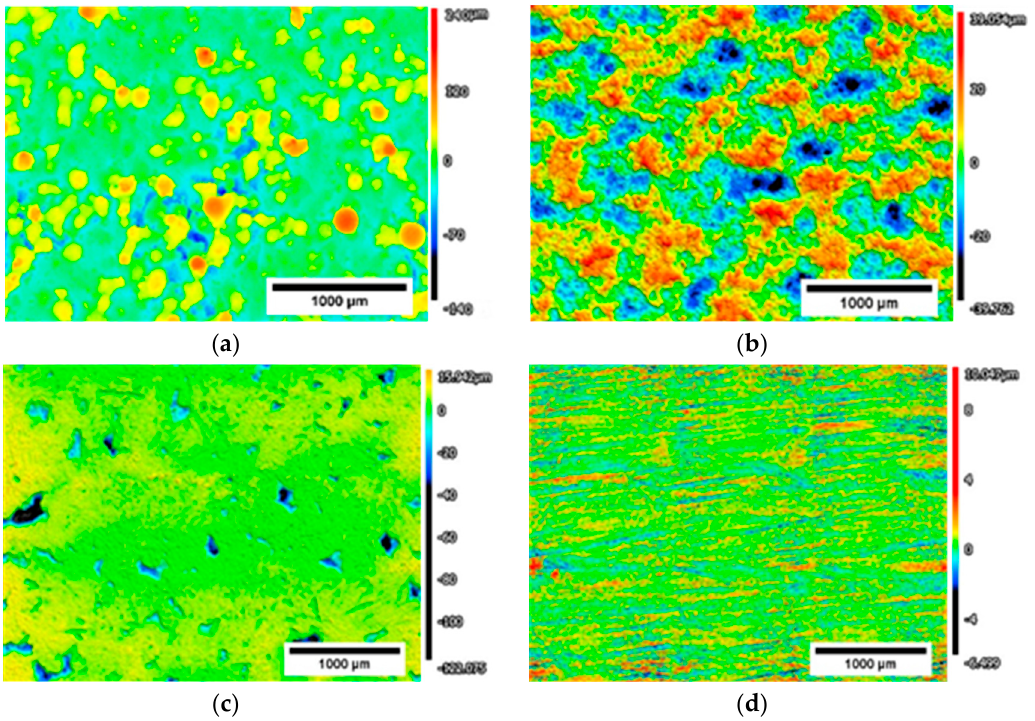
Figure 7. Topographies of the specimens measured by the confocal microscopy: ( a ) as-built; ( b ) SB; ( c ) VF; ( d ) MP.